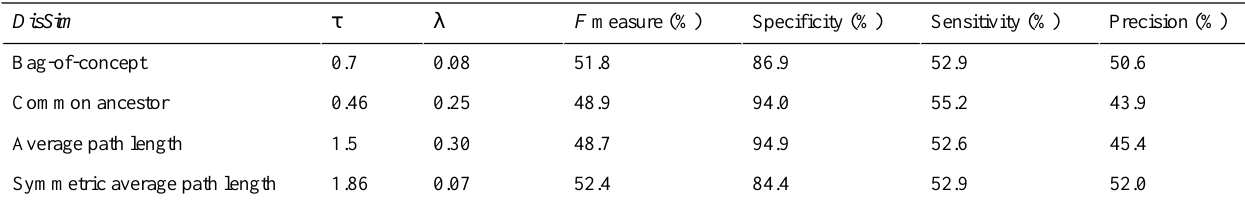
Table 1. The best parameters for each distance function based on the training data set.